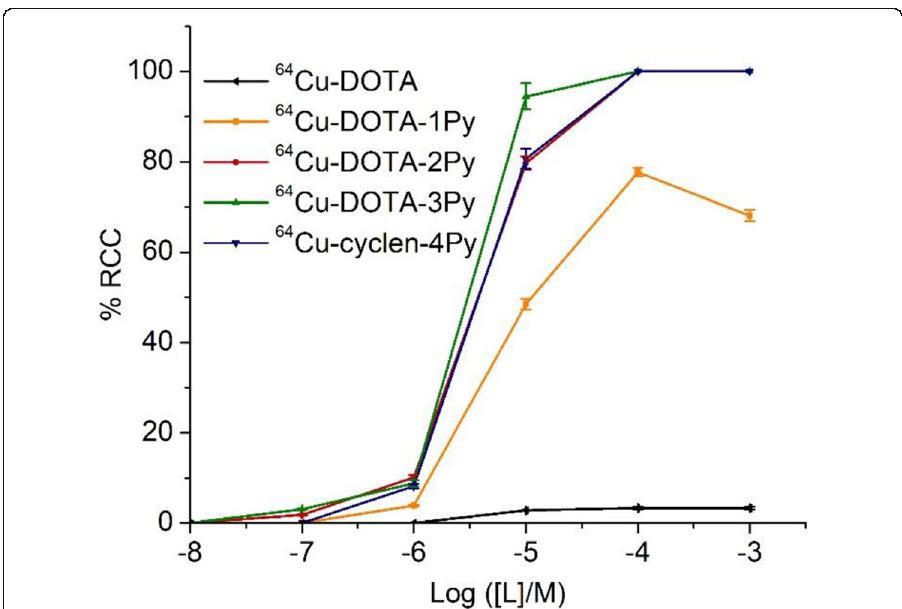
Fig. 3 64 Cu labeling conversion at various ligand concentrations for DOTA, DOTA-1Py, DOTA-2Py, DOTA- 3Py, and cyclen-4Py ( n = 3) at ambient temperature and 5 min reaction time